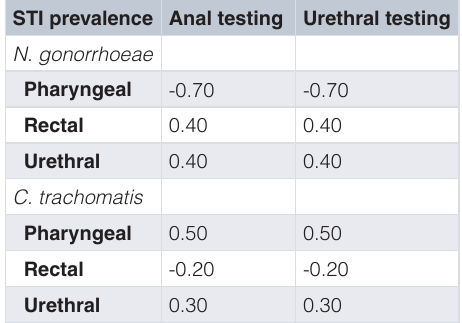
Table 2. Spearman’s correlation between prevalence of sexual transmitted infection (STI) screening (anal and urethral) and prevalence of Neisseria gonorrhoeae and Chlamydia trachomatis (pharyngeal, rectal and urethral). All P-values were greater than